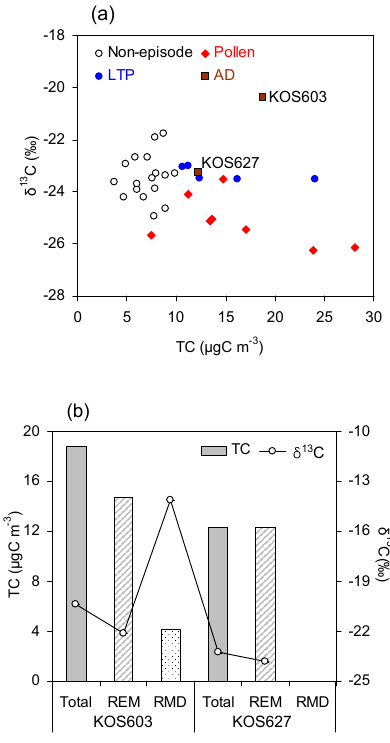
Fig. 7. (a) δ 13 C TC values as functions of TC mass concentra- tions and (b) TC mass concentrations and δ 13 C TC values in the aerosol samples collected during the AD+LTP episodes before and after HCl fume treatment. REM and RMD represent the remain- ing carbon and the removed carbon after the HCl fume treatment, respectively. KOS603 and KOS627 samples were collected dur- ing the strong AD+LTP (30 March–2 April 2007) and less strong AD+LTP episodes (25–28 May 2007), respectively. The standard deviation of δ 13 C TC was ∼ 0.03‰, and its analytical error was ∼